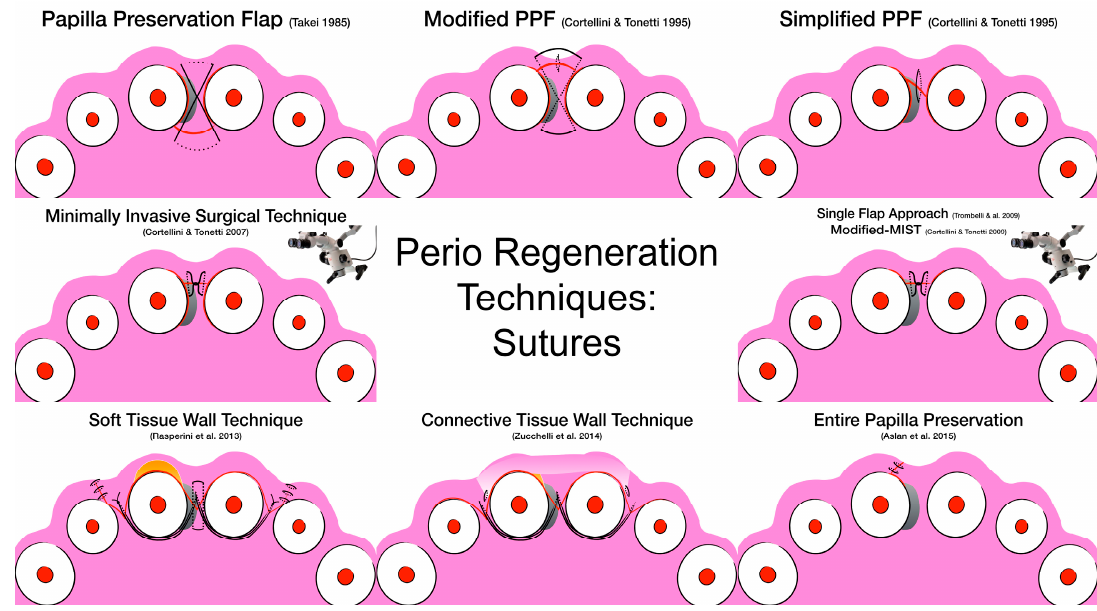
Figure 3. Visual representation of the suturing technique according to surgical technique.